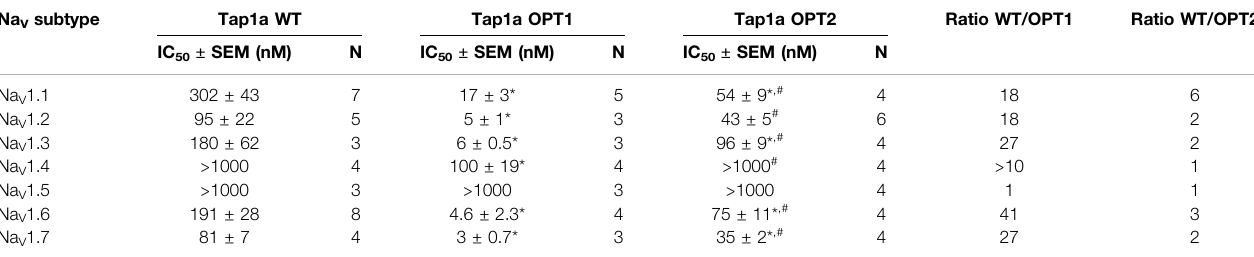
Individual p values are described in the text. *Statistically signi fi cant compared to